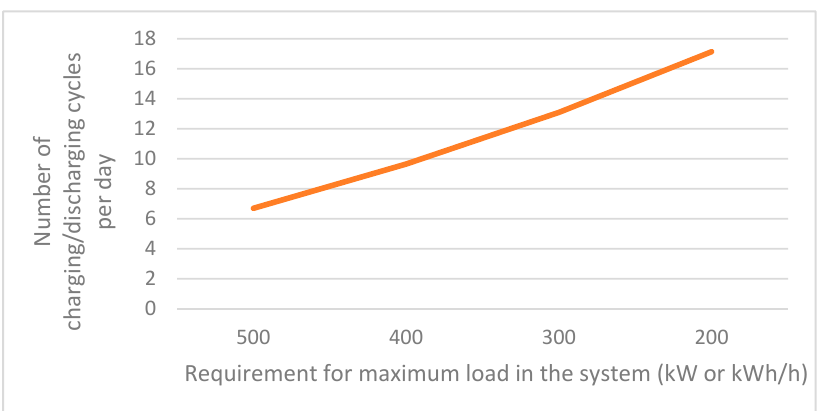
Figure 2. Opportunity charging: Number of charging cycles per day as a function of the load requirement stemming from the EV-charging-associated demand. The graph is based on the rainfall method described in [21].